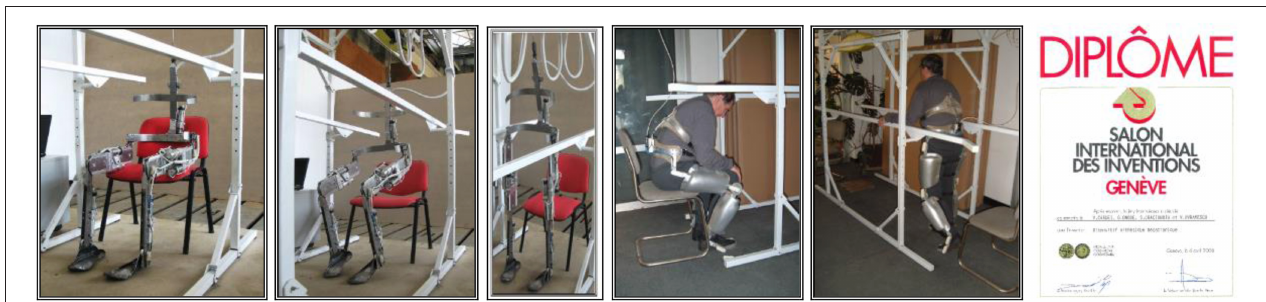
FIGURE 4 | Mechatronic Orthotic Device (MOD) Left: some relevant images of exoskeletons. Right: Award Diploma by the Geneva International Inventions Fair. Reproduced with permission from the publisher (Onose et al., 2012a, pp. 1–99).